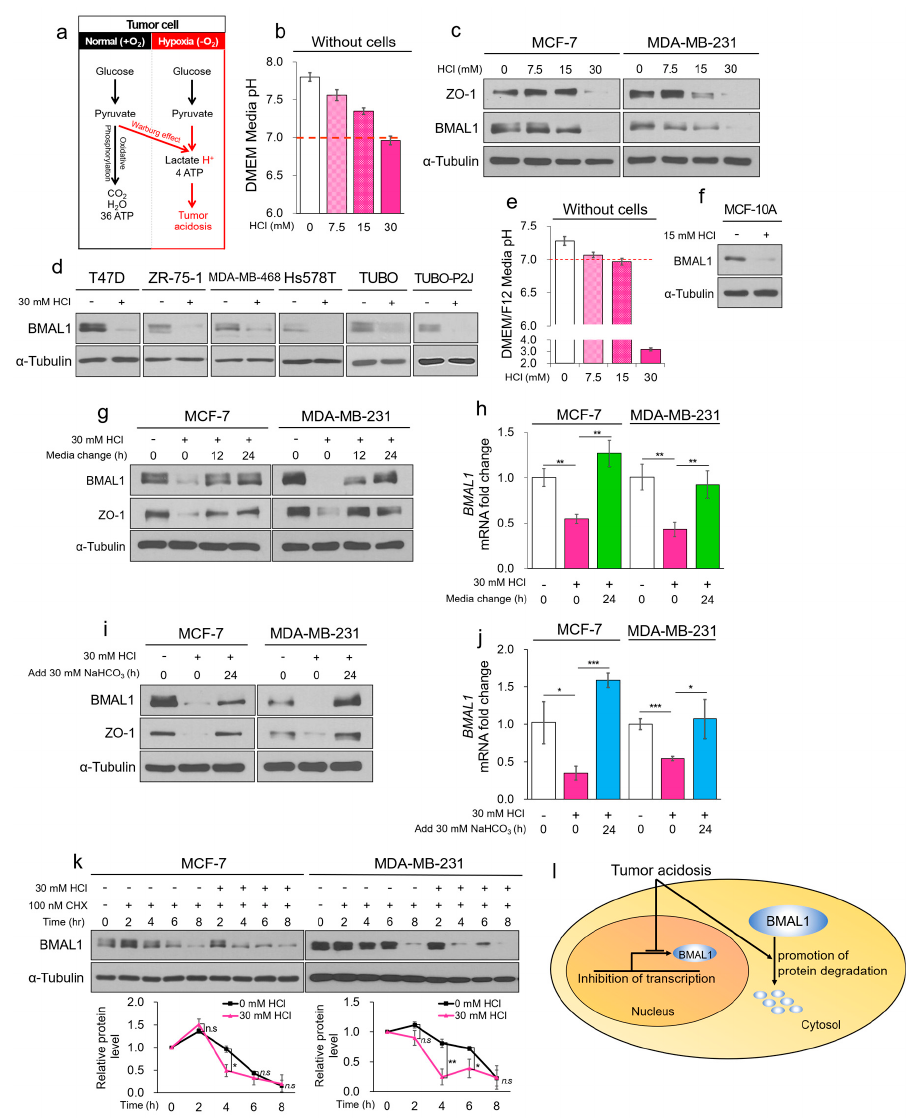
Figure 3. Tumor acidosis reduces BMAL1 via inhibition of transcriptional activity and protein stability in breast cancer cells. ( a ) The summarization of the glycolysis pathway in normoxia and hypoxia. ( b ) HCl-mediated acidic DMEM media were incubated for 24 h without cells, and media pH was immediately measured using a pH meter. ( c , d ) Breast cancer cell lines were treated with HCl-mediated acidic media for 24 h. Cell lysates were analyzed by immunoblotting. ( e ) HCl-mediated acidic DMEM/F12 media were incubated for 24 h without cells. pH of the cultured media was immediately measured using a pH meter. ( f ) MCF-10A was treated with HCl-mediated acidic media for 24 h. Cell lysate was analyzed by immunoblotting. ( g , h ) MCF-7 and MDA-MB-231 were treated with HCl-mediated acidic media for 24 h. The acidic cultured media were exchanged to fresh media and then incubated for 12 and 24 h. Cell lysates were analyzed by immunoblotting ( g ) and RT-qPCR ( h ). ( i , j ) MCF-7 and MDA-MB-231 were treated with HCl-mediated acidic media for 24 h. The acidic cultured media were added to NaHCO 3 and then incubated for 24 h. Cell lysates were analyzed by immunoblotting ( i ) and RT-qPCR ( j ). ( k ) MCF-7 and MDA-MB-231 were treated with CHX in acidic condition for the indicated periods. Cell lysates were analyzed by immunoblotting. The blots of BMAL1 were quantified using ImageJ (bottom panel). ( l ) Graphical summarization of the dual pathways that reduce BMAL1. Data represent the mean ± SD, n = 3. * p < 0.05 and ** p < 0.01 vs. the control group or between two groups by a Student’s t